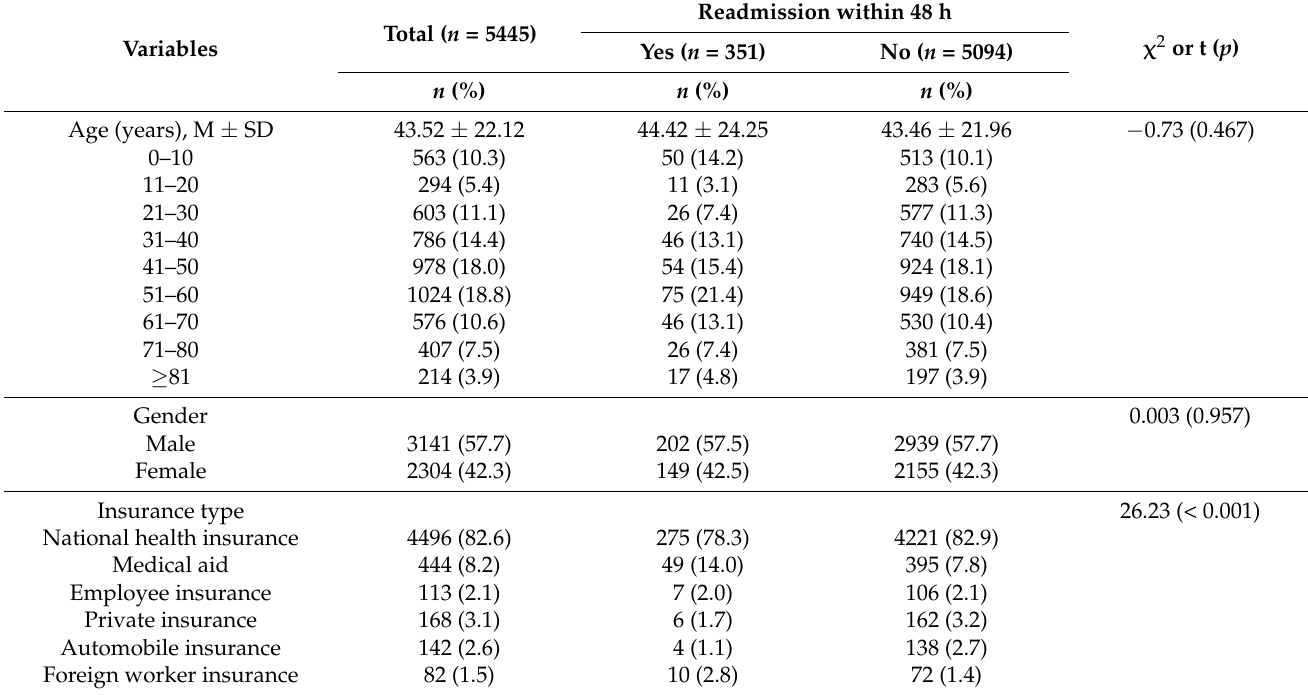
Table 1. Characteristics of study patients stratified by readmission within 48